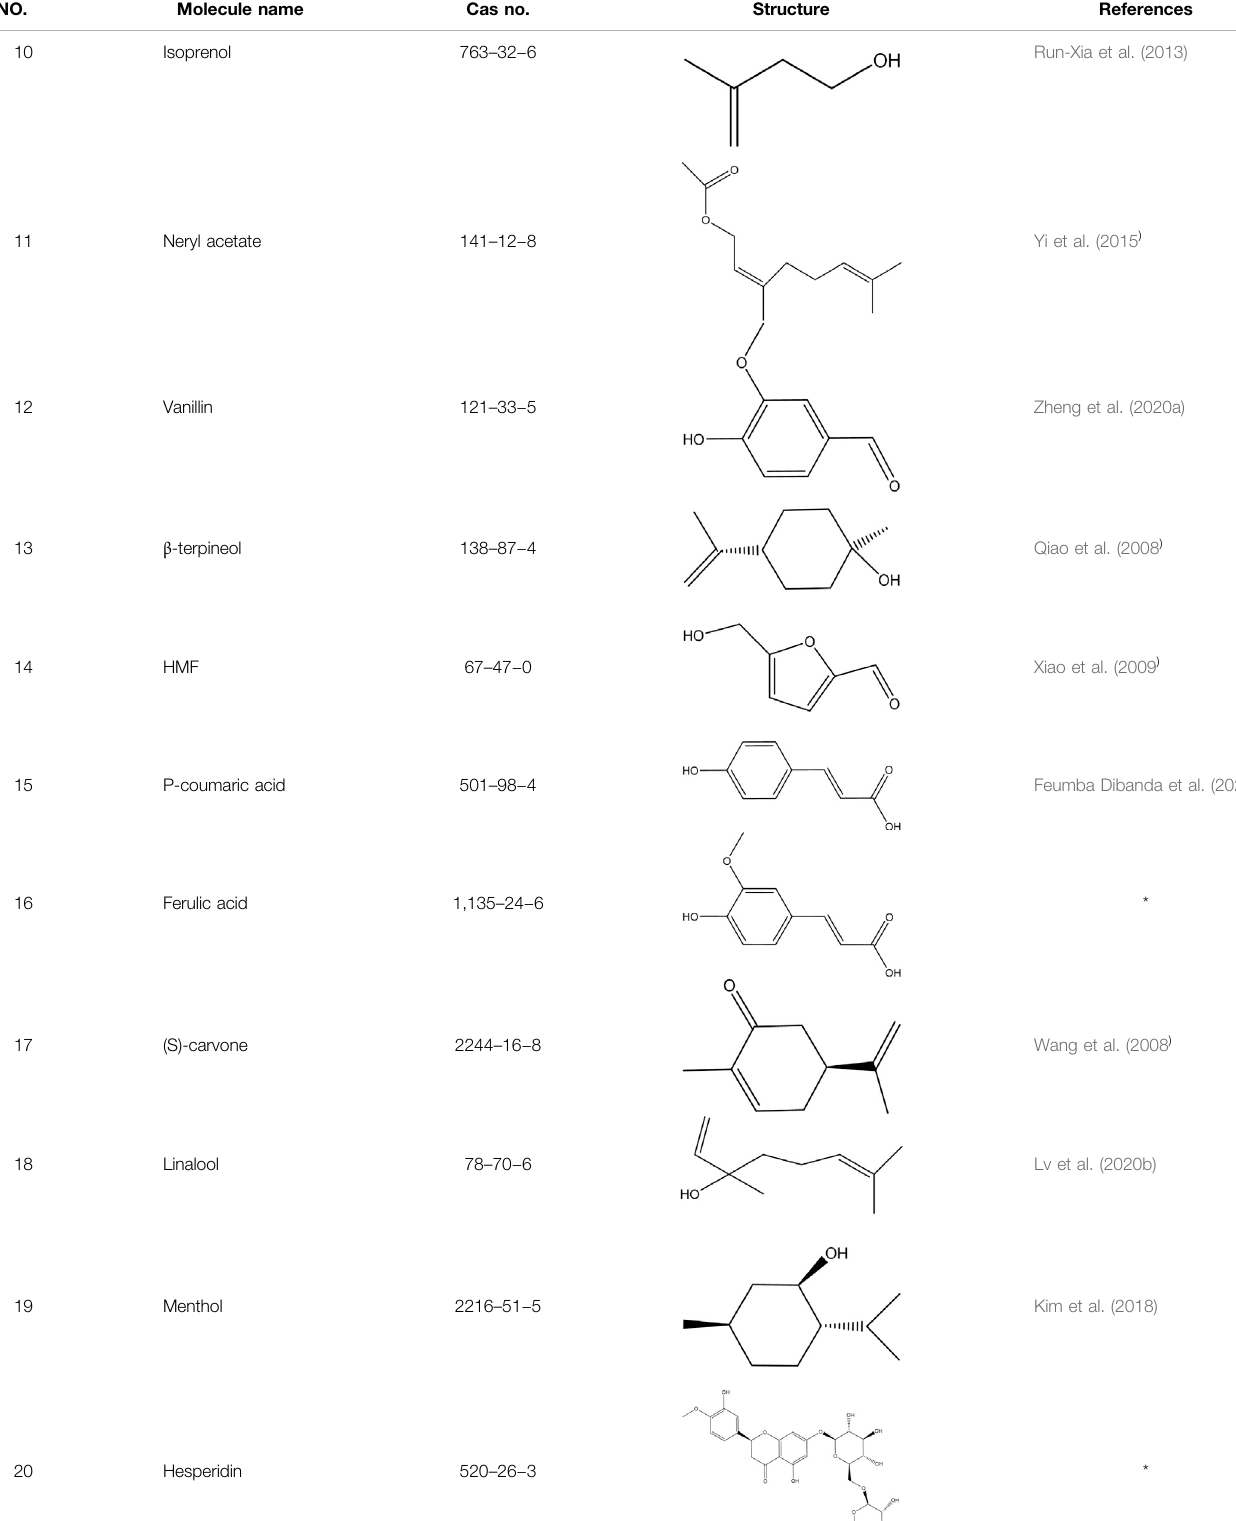
TABLE 2 | ( Continued ) | Final selected compounds per the details of the active compounds in